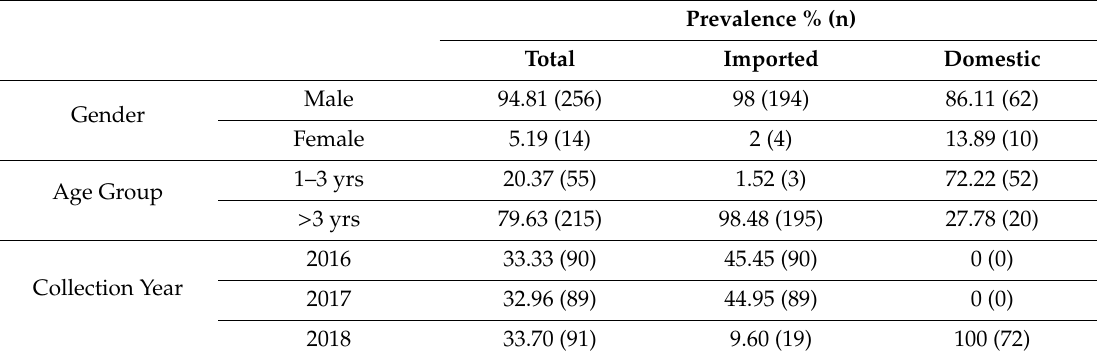
Table 1. Main characteristics of the IgG positive camel